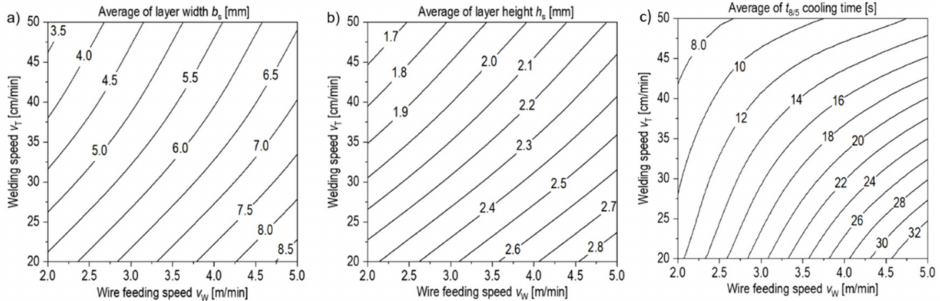
Figure 18. Average layer width ( a ), layer height ( b ) and t 8/5 cooling times ( c ) as a function of the wire feeding and welding speed in the investigated parameter range (contour plots of the regression models) [237].